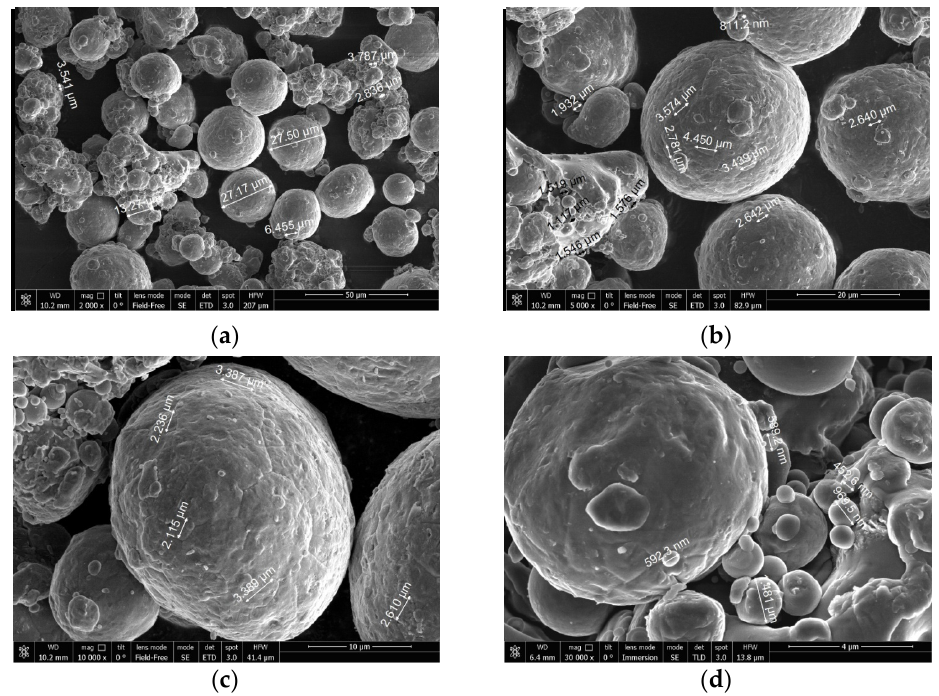
Figure 2. SEM micrographs of magnesium powder. Scale: ( a ) 50 µm, ( b ) 20 µm, ( c ) 10 µm, ( d ) 4 µm. Table 1. Aluminum powder